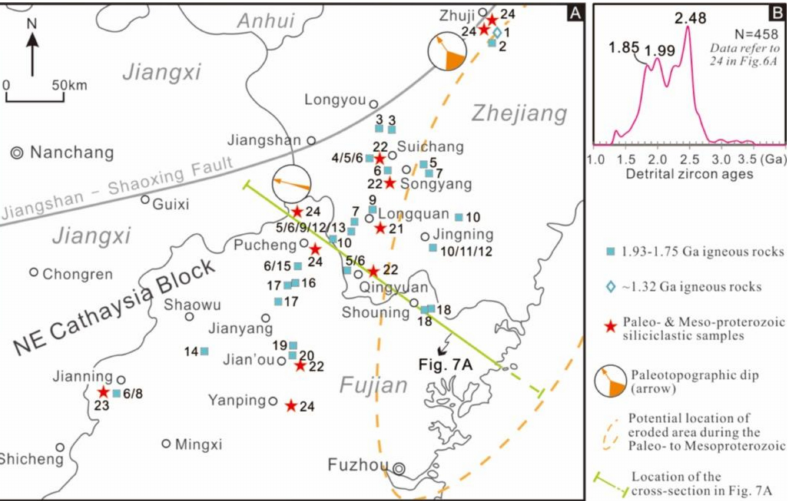
Figure 6. ( A ) Sites of the pre-Neoproterozoic igneous rocks and collected siliciclastic samples in the northeastern Cathaysia block, and paleotopographic dips of the northeastern margin of the Cathaysia block. ( B ) Age spectra of all the dated detrital zircons in this study. Data